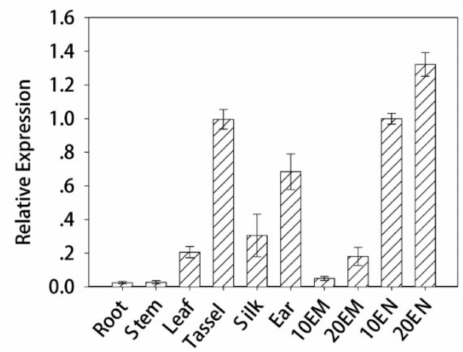
Figure 2. Expression pattern of ZmES22 across diverse tissues. Expression patterns of ZmES22 in root, stem, leave, tassel, silk, ear, embryo and endosperm was quantified via qRT-PCR. The developmental stage of the embryo and endosperm is indicated by 10 and 20 DAP. Maize Actin1 was used as the internal control. Error bars are standard deviations of three technical repeats and two biological repeats.